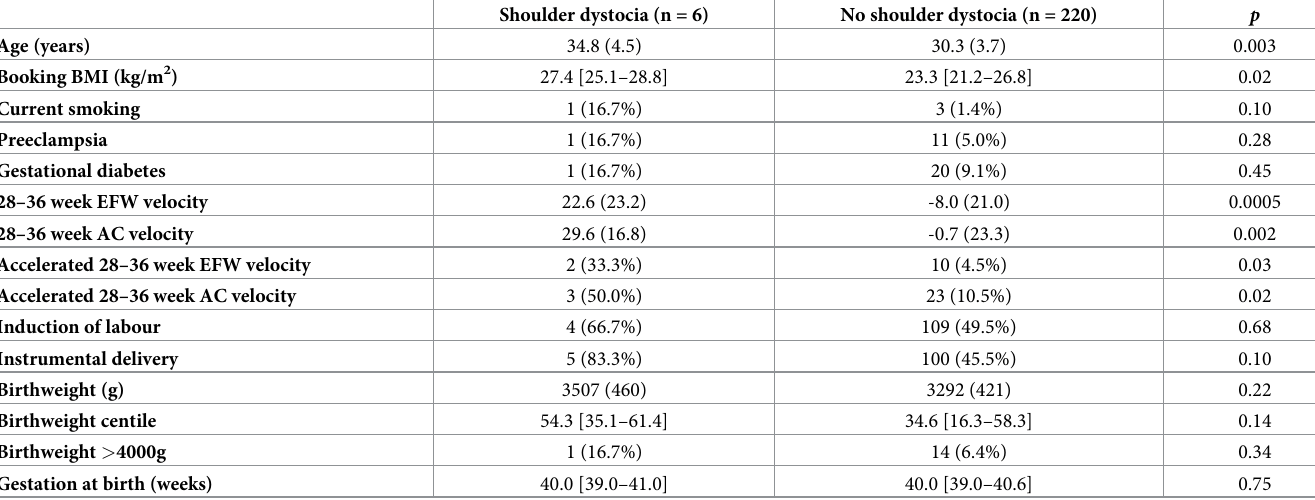
Table 1. Maternal characteristics and delivery outcomes for cases of shoulder dystocia compared to the rest of the cohort.